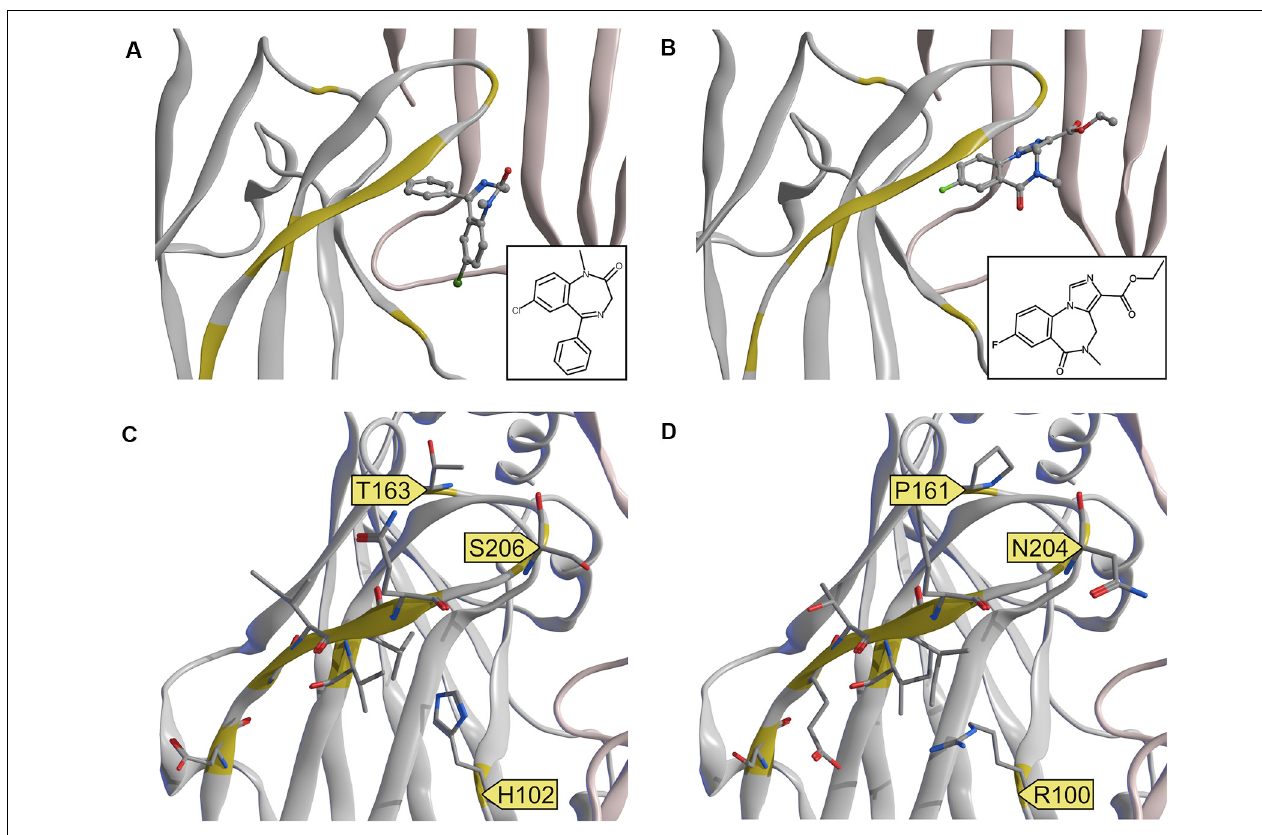
FIGURE 7 | Experimental structures and a homology model of the α 6 subunit. (A,B) Comparison of experimental structures of diazepam and flumazenil at the α 1+/ γ 2 − ECD binding site. 6HUP (A) contains diazepam, 6D6U (B) contains flumazenil. The two ligands do not share a common binding mode. (C) 6HUP and (D) α 6 homology model, both with amino acids, which differ between the two α isoforms in stick representation. Amino acids that could facilitate DI selective or even α 6 selective targeting are highlighted with a yellow